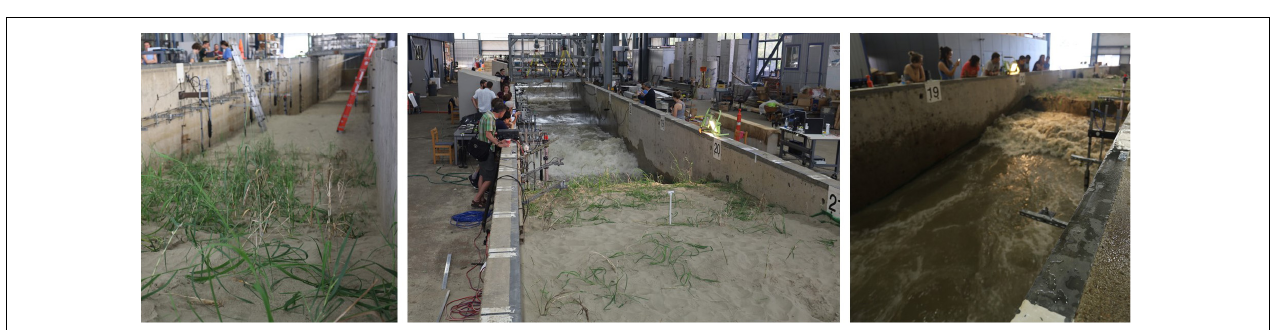
FIGURE 14 | Detail of vegetated duneand instrumentation (left) , overview of the LWF during testing (center) , and wave impact on dune (right) .